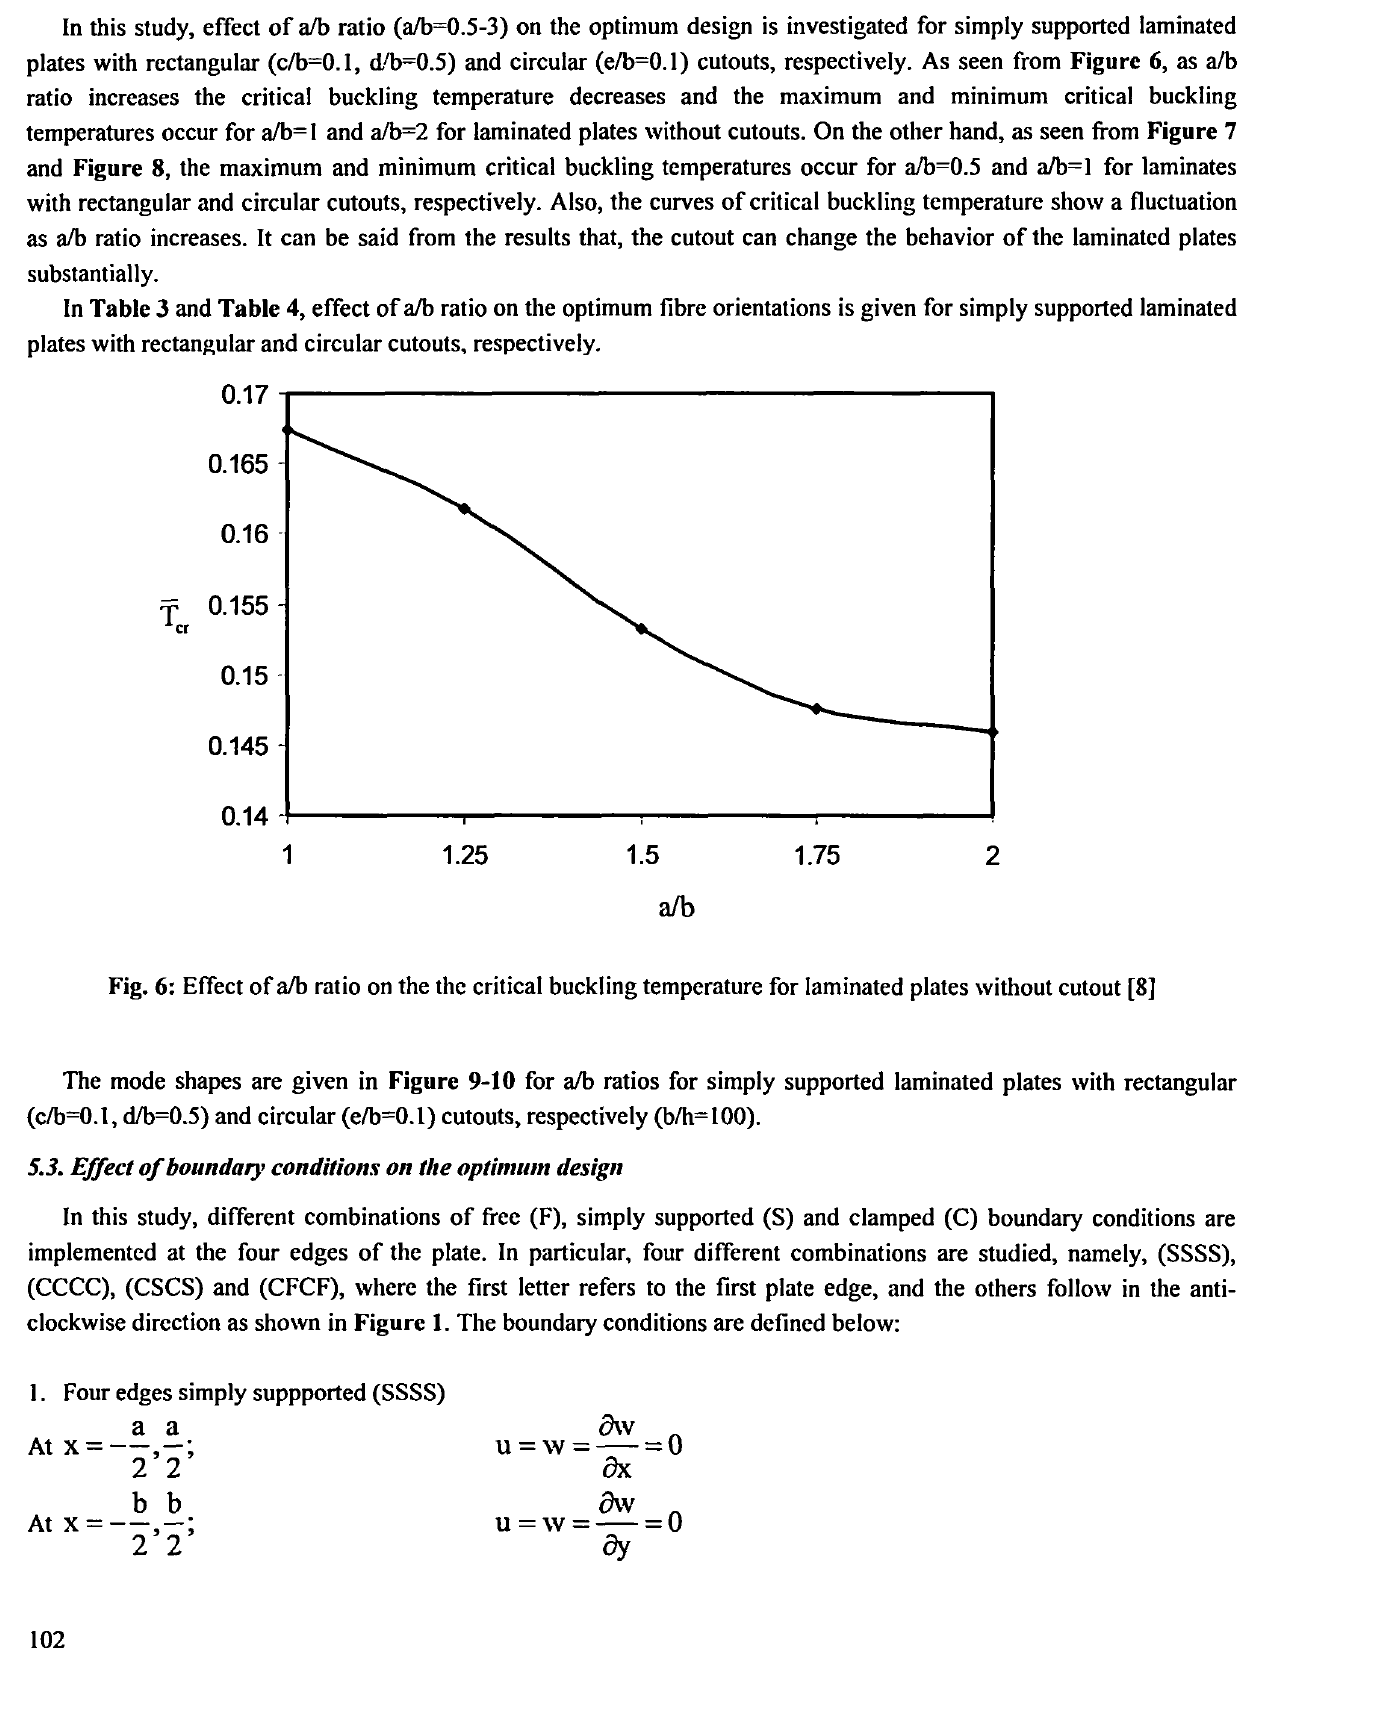
Fig. 6: Effect of a/b ratio on the the critical buckling temperature for laminated plates without cutout [8]